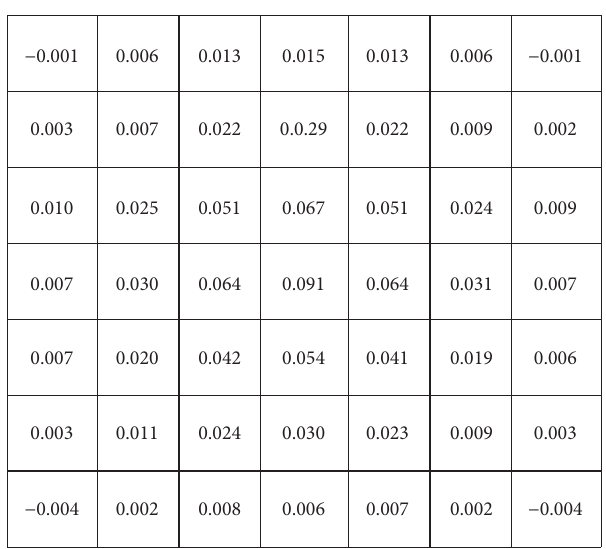
Figure 9: Coefficients of 7 × 7 LMS